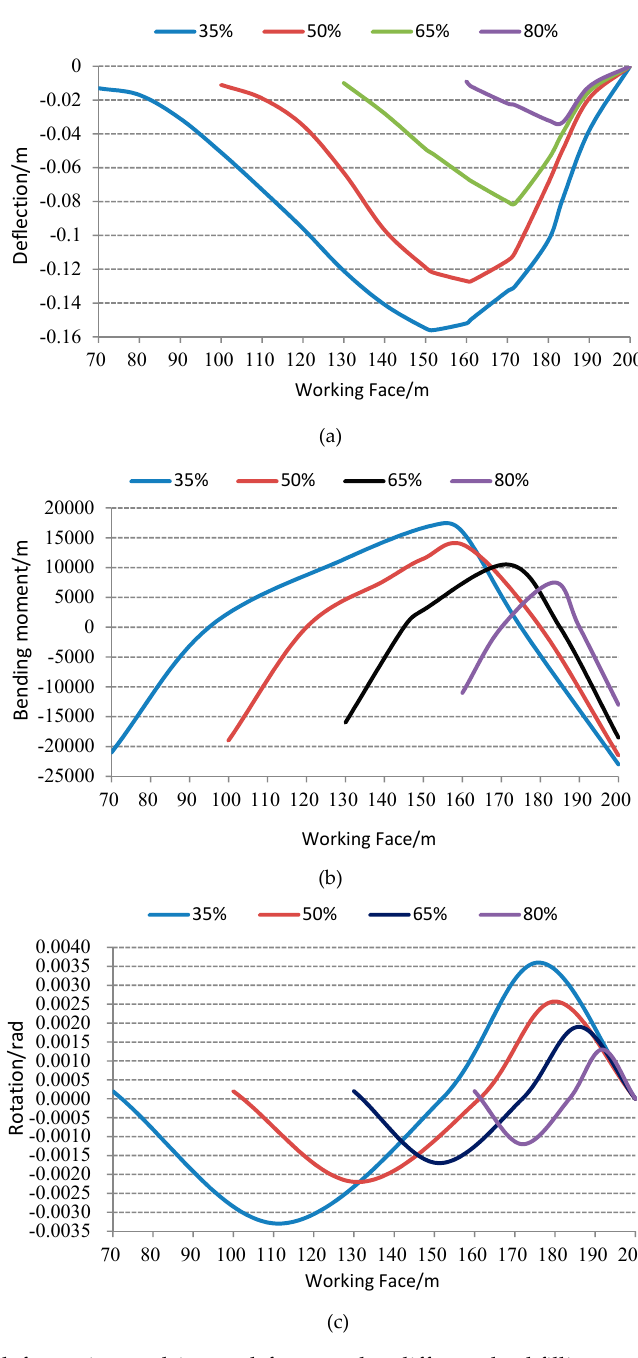
Figure 6. Roof deformation and internal force under different backfilling ratios: ( a ) Deflection; ( b ) bending moment; and ( c ) rotation.